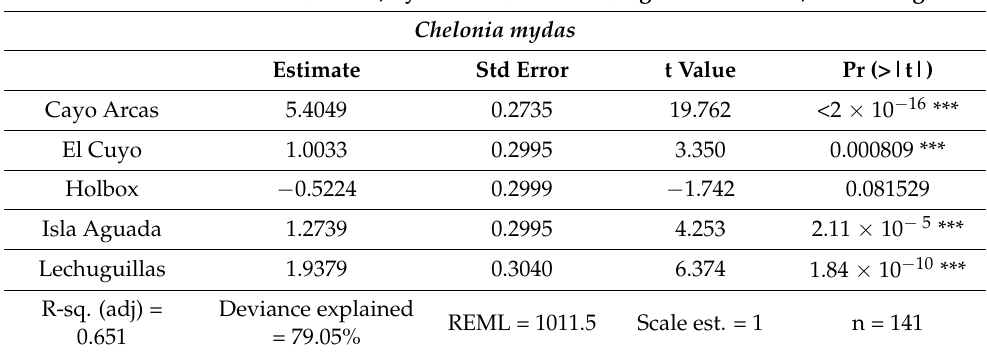
Table 3. Results of the Generalized Additive Models to evaluate the temporal effects of the nesting season on the number of nests of green ( Chelonia mydas ) sea turtles at five nesting beaches in the Gulf of Mexico. San Lorenzo and Celest ú n were excluded from the analysis due to their small sample size. N Nest as Function of s (Season, by = Beach) + Beach (Negative Binomial, Link = Log)